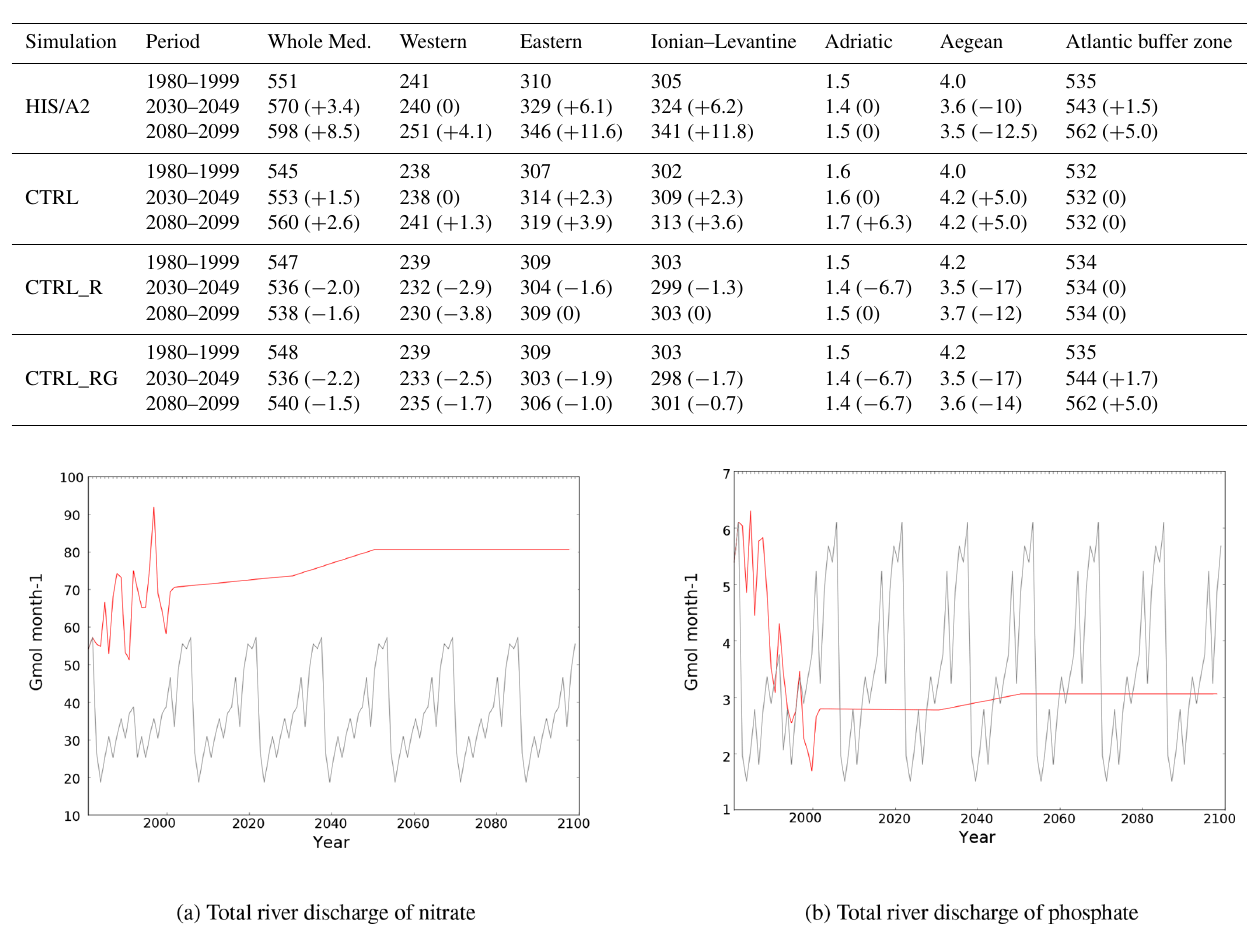
Table 2. Simulated integrated phosphate content (10 9 mol) over 20-year periods in the Mediterranean sub-basins in the different simulations. Basins are the same as defined in Fig. 2 of Adloff et al. (2015), with the eastern basin including the Ionian, Levantine, Adriatic, and Aegean sub-basins. Values in parenthesis indicate the percentage difference from the 1980–1999 period.